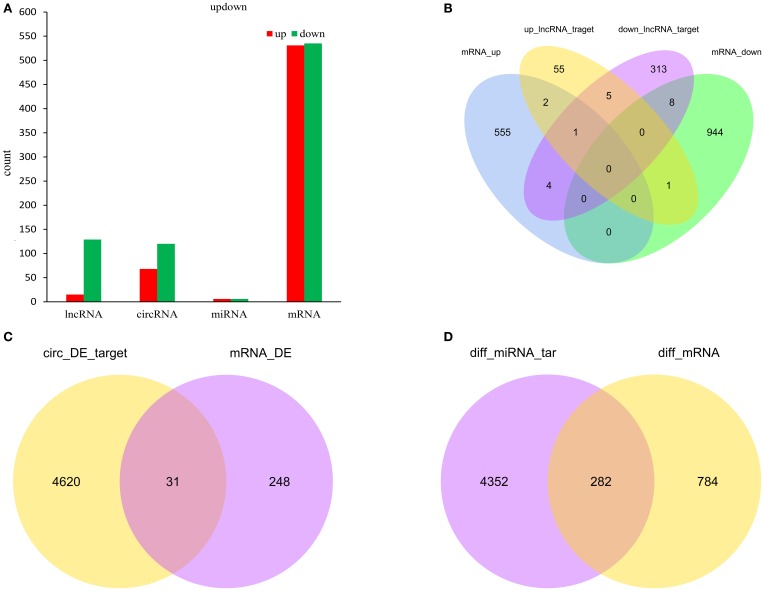
Count of relatived ncRNAs and mRNAs in spinal cord of SNI rats. Histogram showing the number of up and down regulated ncRNAs and mRNAs in spinal cord of SNI rats (A); Venn diagram showing the overlap number of targeted mRNA of up-regulated lncRNAs, targeted mRNA of down-regulated lncRNAs, up-regulated mRNAs and down-regulated mRNAs (B); Venn diagram showing the overlap number of targeted mRNA of DE circRNAs and DE mRNAs (C); Venn diagram showing the overlap number of targeted mRNA of DE miRNAs and DE mRNAs (D).